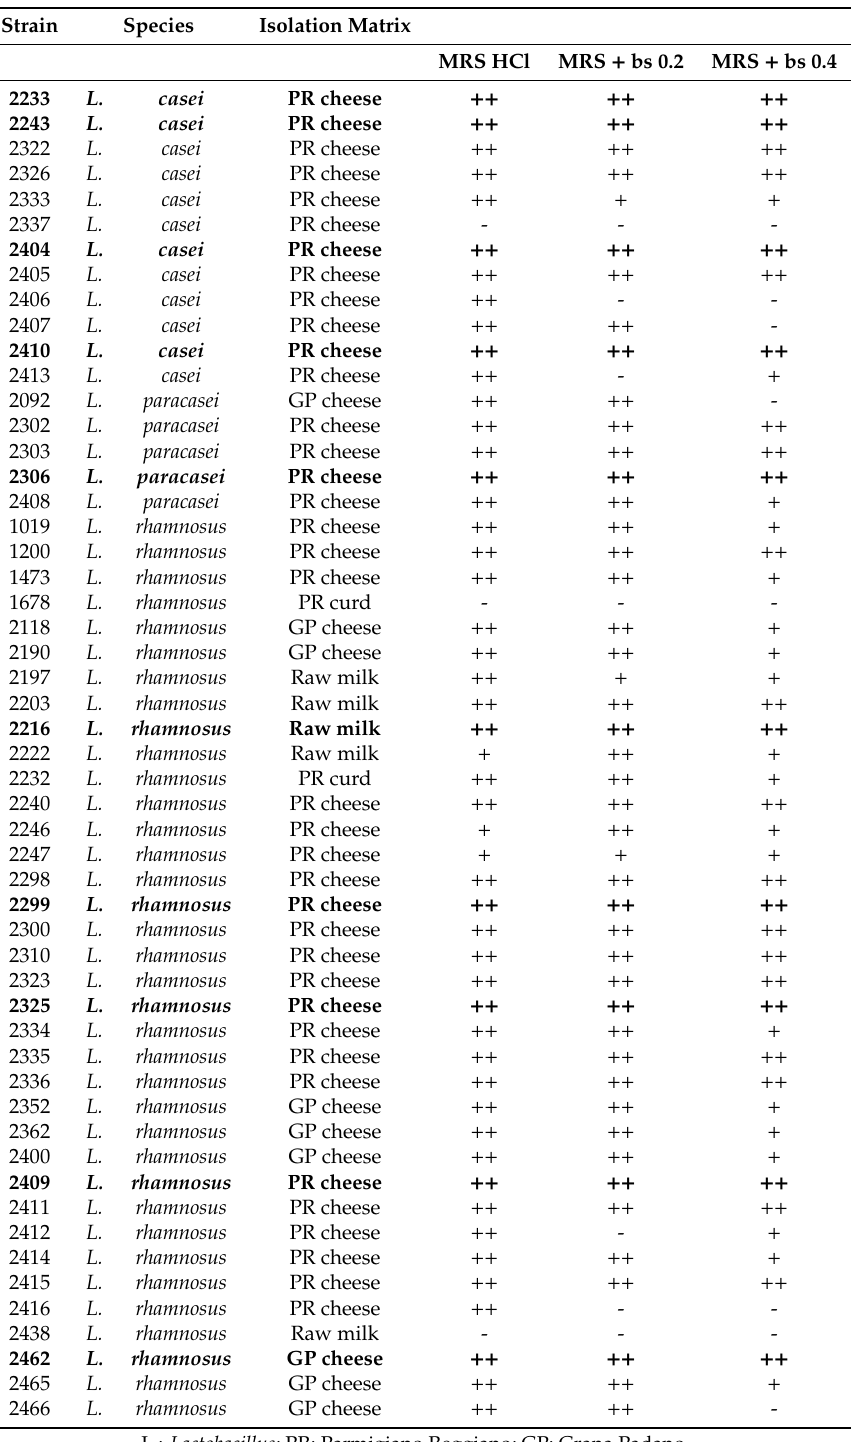
Table 1. Strains’ resistance to acid and bile salts. For each strain, the collection number, species and isolation matrix are given. Results are reported as absence of growth ( − ), low growth, ( ++ ) abundant growth. Strains written in bold were chosen for further